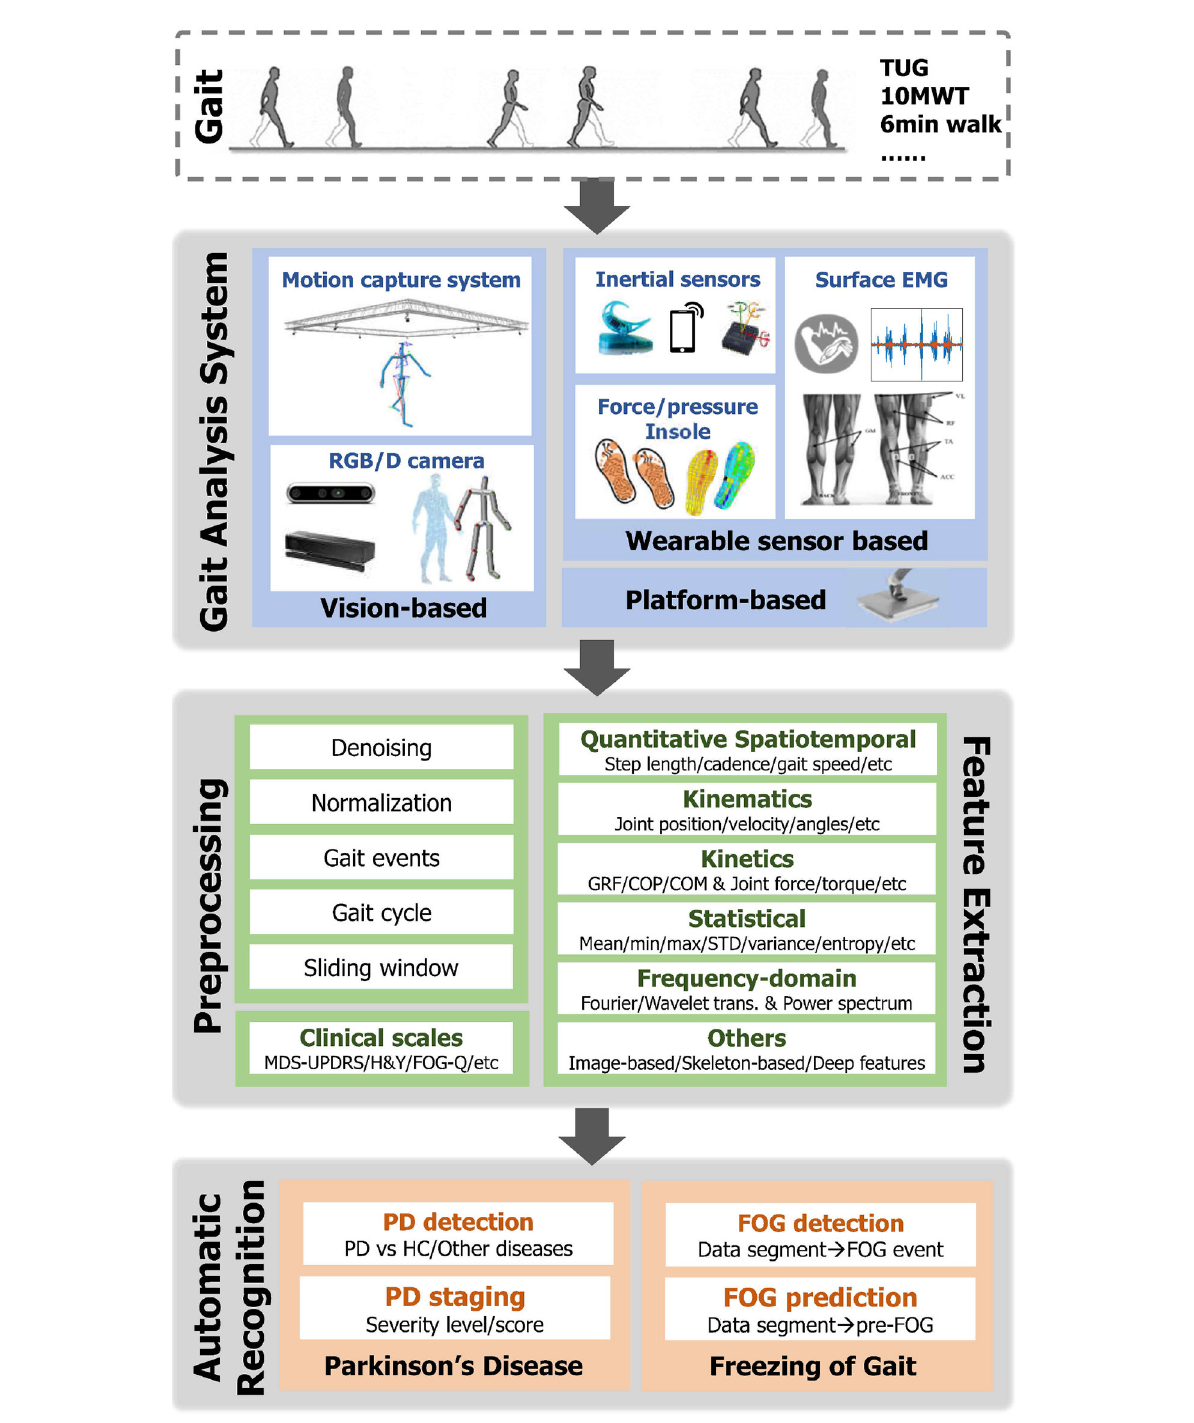
FIGURE3 Illustration of the pipeline for automatic recognition in PD based on Gait Data. ROM, Range of Motion; GRF, Ground Reaction Force; COP, Center of Pressure; COM, Center of Mass; trans., transformation; PD, Parkinson’s Disease; HC, Healthy Control; FOG, Freeze of